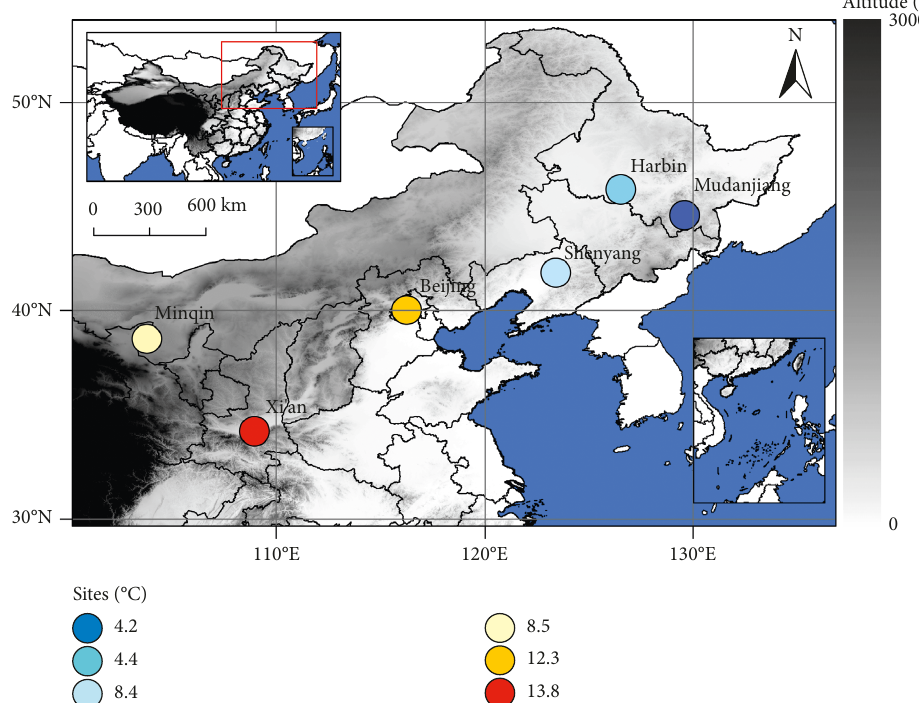
Figure 1: The location and the background of the phenological observation sites in this study. The colors of the circles indicate the annual mean temperature during 1960–1990 for each